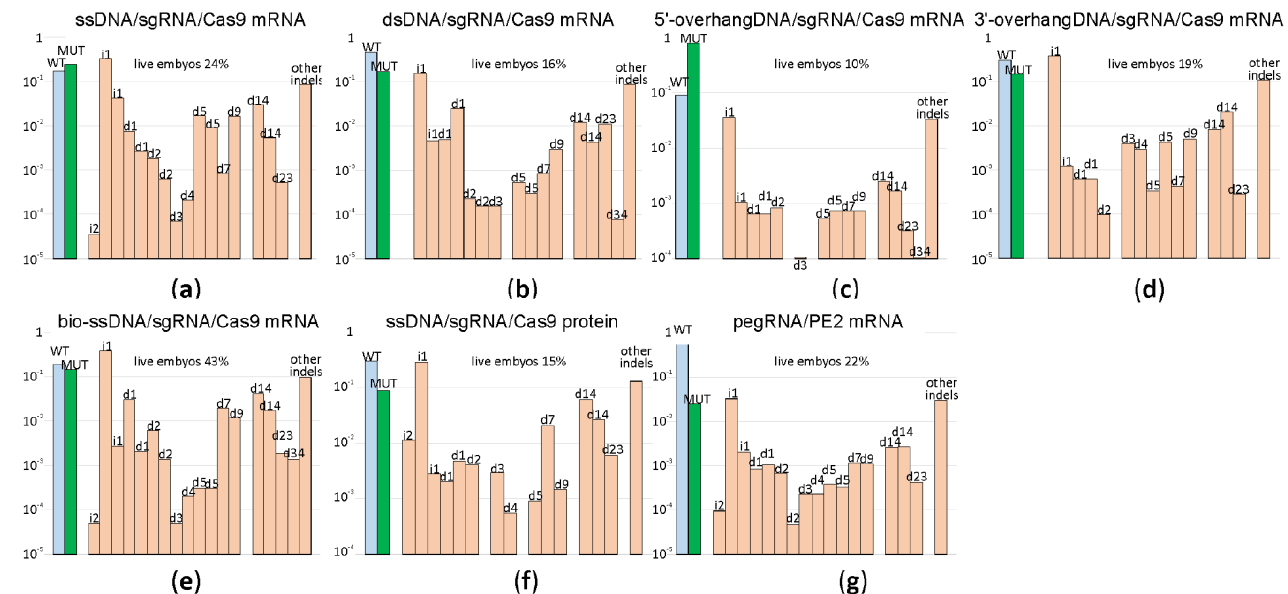
Figure 4. Comparison of genome editing efficiencies for HR programmed by different types of templates as well as alternative methods of genome editing. Shown are frequencies of allelic variants, in the logarithmic scale, detected in the blastocysts developed from the zygotes after microinjection. Blue bars correspond to the wild type genotype, green to the mutation programmed by a template, while pale red to insertions and deletions. Allelic variants are designated above the bars. ( a ) Frequency of genome editing products by sgRNA directed cleavage and ssDNA guided HR; Cas9 was provided by injection of Cas9 mRNA. ( b ) Frequency of genome editing products by sgRNA directed cleavage and dsDNA guided HR; Cas9 was provided by injection of Cas9 mRNA. ( c ) Frequency of genome editing products by sgRNA directed cleav- age and HR guided by DNA template with 5′-overhang; Cas9 was provided by injection of Cas9 mRNA. ( d ) Frequency of genome editing products by sgRNA directed cleavage and HR guided by DNA template with 3′-overhang; Cas9 was provided by injection of Cas9 mRNA. ( e ) Frequency of genome editing products by sgRNA directed cleavage and bioti- nylated ssDNA guided HR; Cas9-mSA was provided by injection of Cas9-mSA mRNA. ( f ) Frequency of genome editing products by sgRNA directed cleavage and ssDNA guided HR; Cas9 was provided by injection of Cas9 protein. ( g ) Fre- quency of genome editing products by pegRNA directed cleavage and reverse transcription by PE2. For each construct, the percentage of zygotes developed to the blastocyst or morula stage is indicated above the graph.